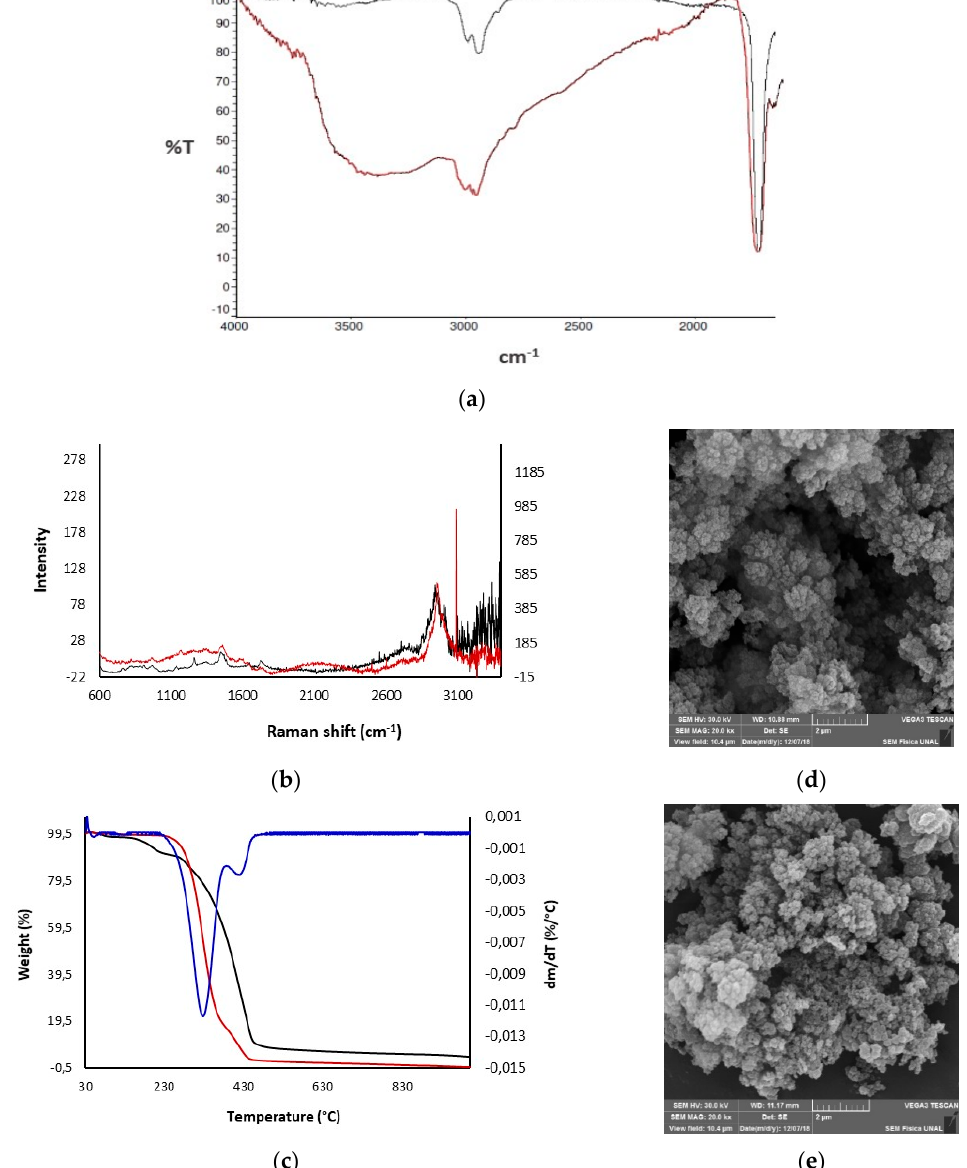
Figure 3. Characterization of the modified polymer 7 -poly(GMA- co -EDMA) ( 8 ) (red) in comparison with the unmodified polymer 1 (black). ( a ) ATR-FT-IR spectra. ( b ) Raman spectra. ( c ) Thermogravimetric analysis (TGA) thermograms and curve dm/dT of 8 (blue). Scanning electron micrographs at 2 µ m, ( d ) 1 and ( e ) 8 .